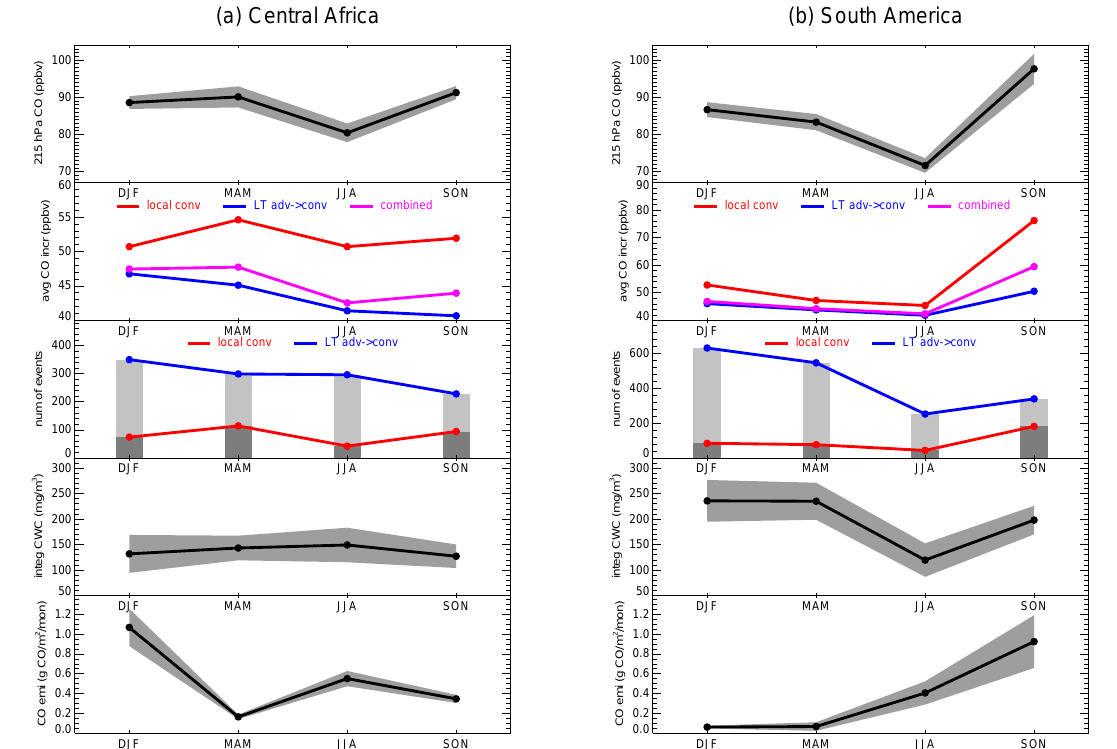
Fig. 8. Seasonal variation of: (top panel) MLS CO at 215hPa (scaled by 0.5); (second panel from top) average CO increase associated with the “local convection” pathway (red line), with the “LT advection → convection” pathway (blue line) and with the combination of both pathways (purple line); (third panel from top) number of “local convection” pathway events (dark grey, red line) and number of “LT advection → convection” pathway events (light grey, blue line); (fourth panel from top) CloudSat vertically-integrated CWC above 6km; and (bottom panel) GFED3 surface CO emission for (a) Central Africa (20 ◦ S–20 ◦ N, 16 ◦ W–40 ◦ E) and (b) South America (24 ◦ S–12 ◦ N, 88–32 ◦ W) from December 2006–November 2007. The gray shaded areas around the 215hPa CO, CWC and CO emission curves indicate ± 2 standard errors of the mean.